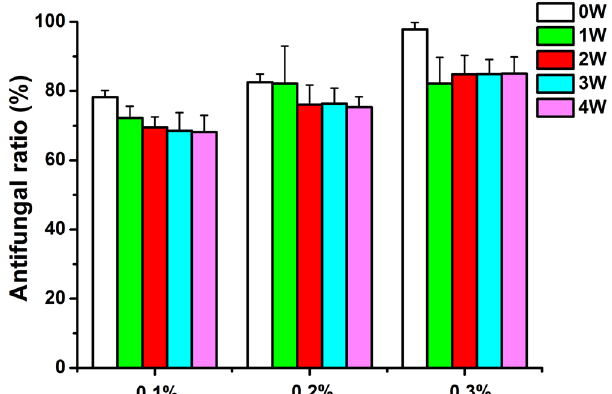
Figure 6. Histogram of the antifungal ratio of PMMA resin. Each value is the mean ± SD (n = 9). With the increase in AgBr/NPVP, the antifungal activity of unaged PMMA resin increased, and there were significant differences (P < 0.017) among the groups. The antifungal ratio of 1-week aging groups decreased compared with the corresponding unaged groups. Furthermore, the 0.3 wt% group decreased significantly. However, the antifungal ratio of each group showed a stable trend after 2 w of aging, and the 0.3 wt% group had the best antifungal effect, reaching more than